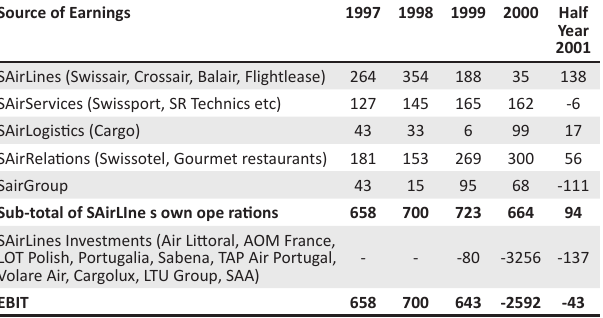
TABLE 1: Breakdown of SAirGroup 2000 earnings before income tax by business unit. Source of Earnings